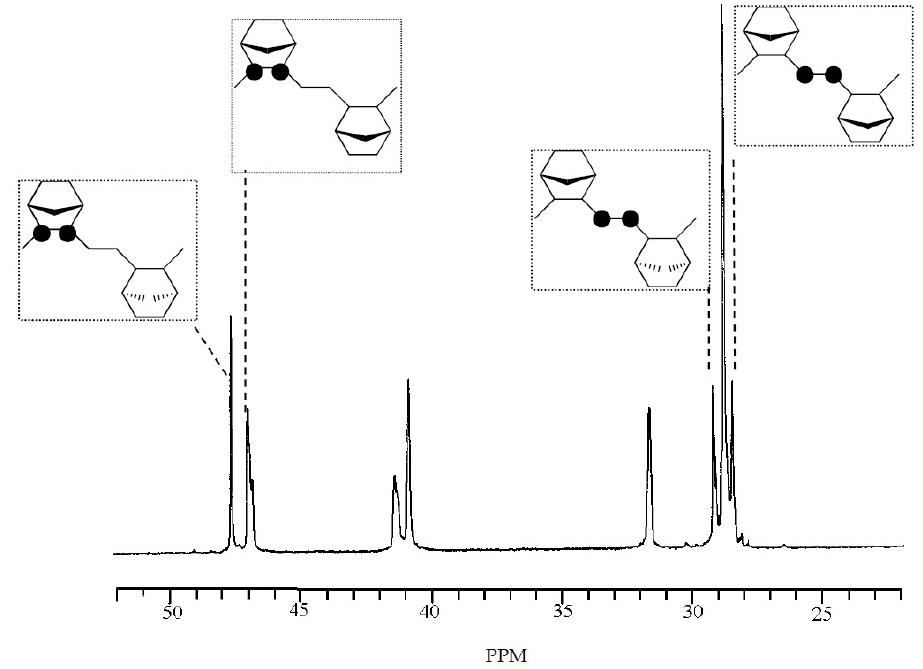
Figure 2. 13 C NMR spectrum of an alternating atactic E- co -N copolymer prepared with 6 catalyst. [34].